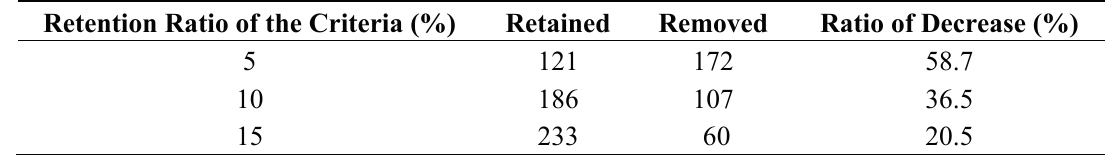
Table 5. Number of air monitoring stations for various retention ratios of the criteria. Retention Ratio of the Criteria (%)